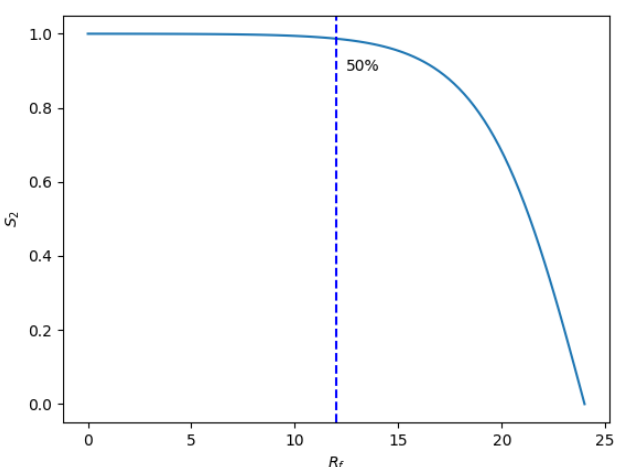
Figure 7. An illustrative example of the evolution of the value of S 2 as a function of the value of R f , for an anomaly of a sequence of 24